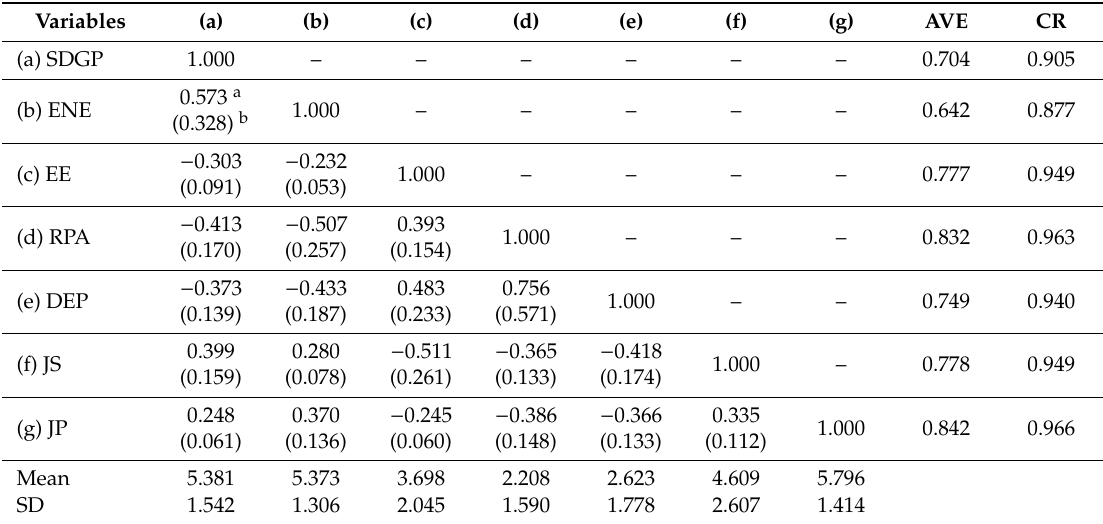
Table 1. Correlation, mean, standard deviation, average variance extracted, and reliability ( n = 309).